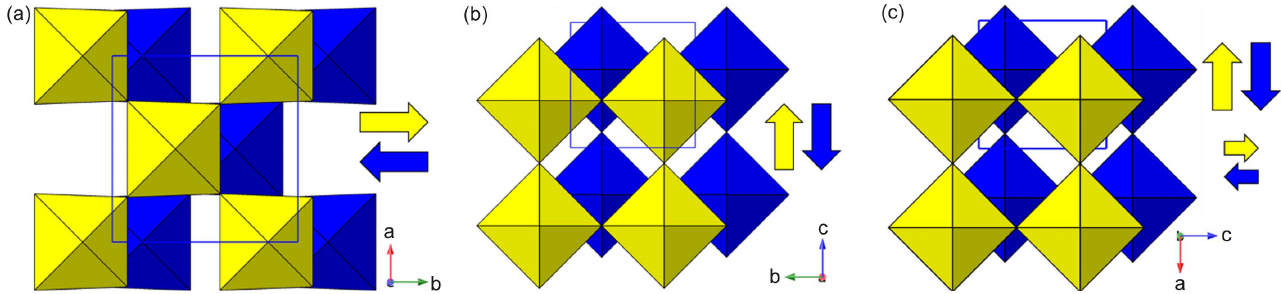
Figure 3 Three distinct M 5 (cid:2) displacive modes, derived from the RP parent. ( a ) M 5 (cid:2) (a, 0) antiparallel displacements of adjacent layers along one in-plane axis of the supercell; ( b ) M 5 (cid:2) (a, a) showing anti-parallel displacements of adjacent layers along one in-plane axis of the parent cell; ( c ) M 5 (cid:2) (a,b) allows two different amplitudes of displacement along the in-plane axes of the parent cell. It can be seen that the (a, 0) mode results in layers shifted towards DJ type, (a, a) towards DJ2 type, and (a, b) provides both degrees of freedom. Note that each mode also allows a distortion of the octahedra, which is illustrated in ( a ) by the differing lengths of the trans -octahedral edges.